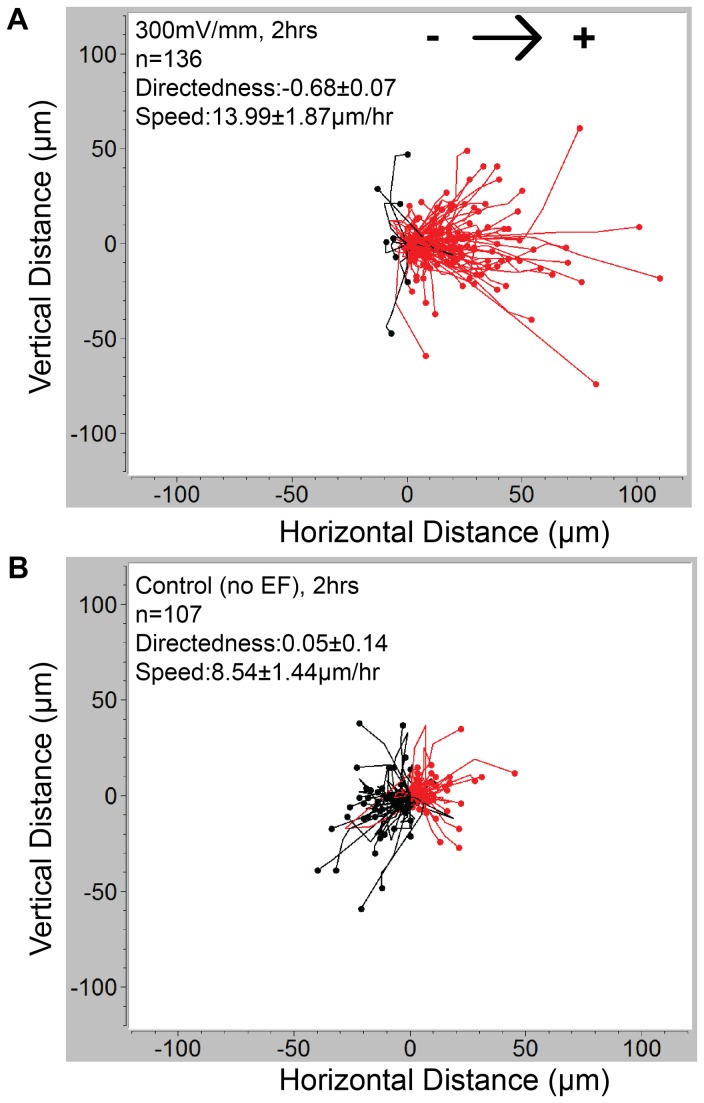
The migration trajectories of CL 1-5 cells for 2 hours in serum-containing medium.(A) CL 1-5 under 300mV/mm dcEF shows anodal electrotaxis. Cell tracks with end positions to the right appear in red and those to the left appear in black. (B) The random migration of CL 1-5 cells without dcEF stimulation.